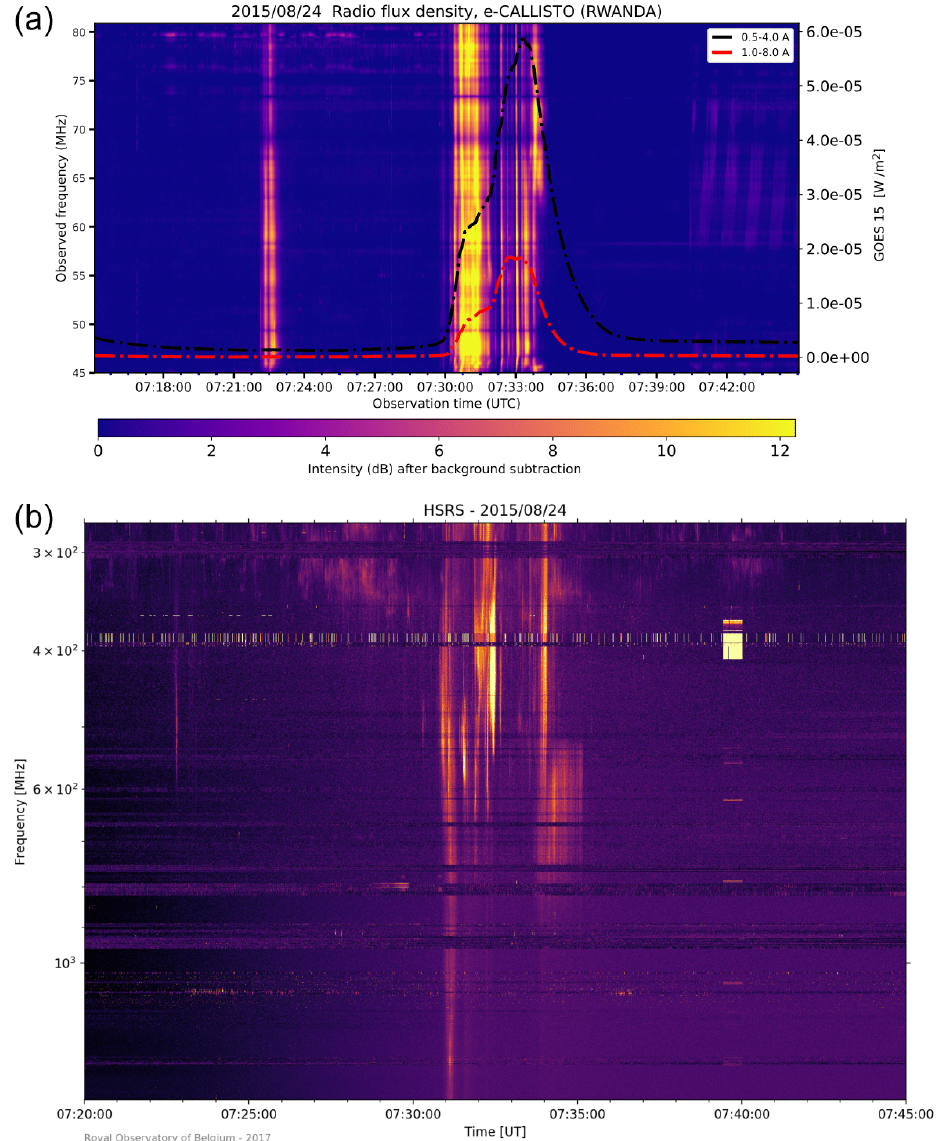
Figure 1. Dynamic spectrum of 24 August 2015 type III radio bursts. (a) An isolated type III burst at 07:22UT followed by a group of type III bursts observed at 07:30UT by CALLISTO Rwanda. (b) A group of type III bursts observed at 07:30UT by the ROB observatory. The one at 07:22UT occurred during the decaying phase of a C 6 . 7 flare (started, peaked, and ended at 07:08, 07:12 and 07:15UT, respectively). A group of type III bursts at 07:30UT is triggered by a M5.6 flare in its rise phase (started at 07:26UT, peaked at 07:33UT and ended at 07:35UT, respectively). The black and red curves show the GOES X-ray